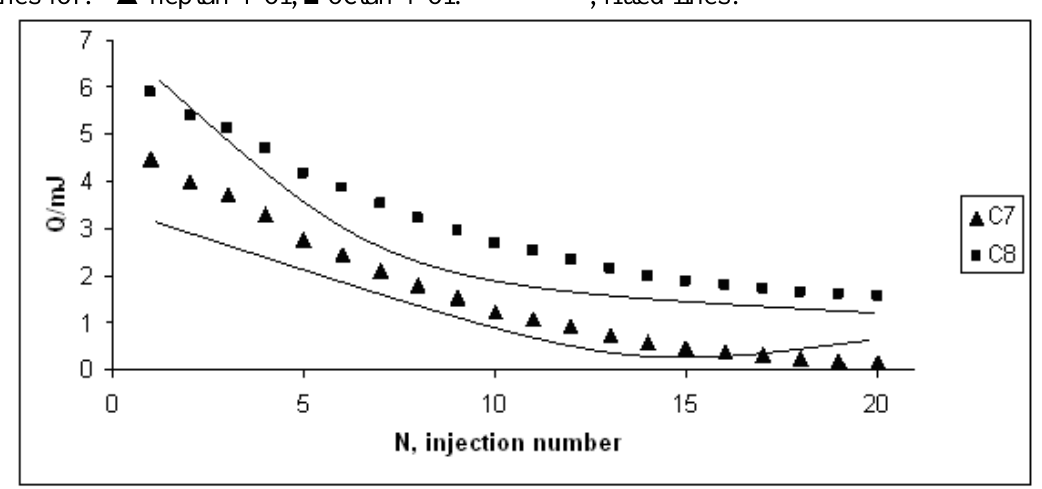
Figure 3 . Heat evolution per injection, Q, plotted against injection number, N. The fitted lines for: ▲ heptan-1-ol, ■ octan-1-ol. ————, fitted lines.